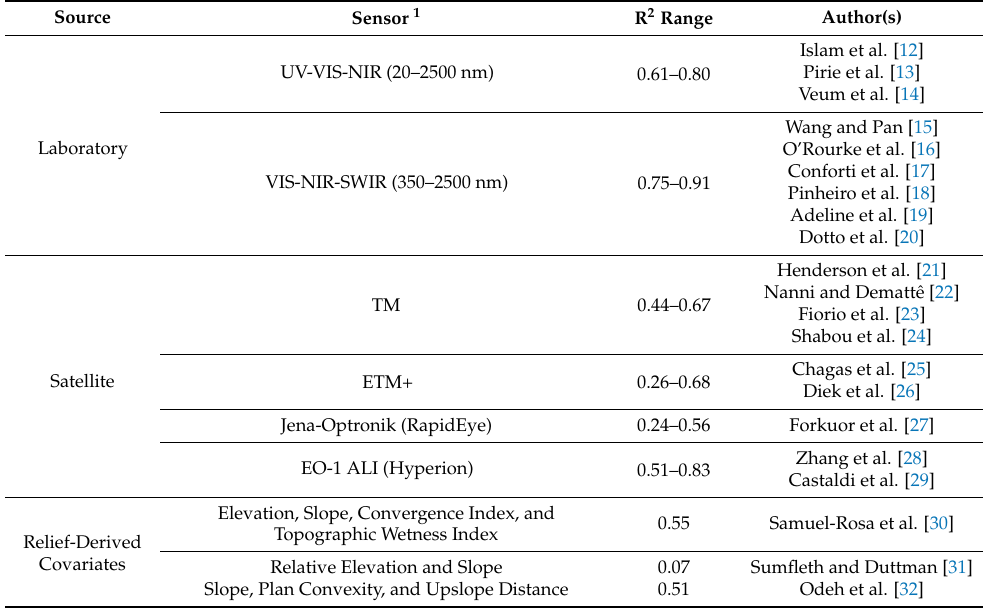
Table 1. Literature review concerning prediction of clay content by laboratory spectral data, satellite multispectral data, and relief-derived